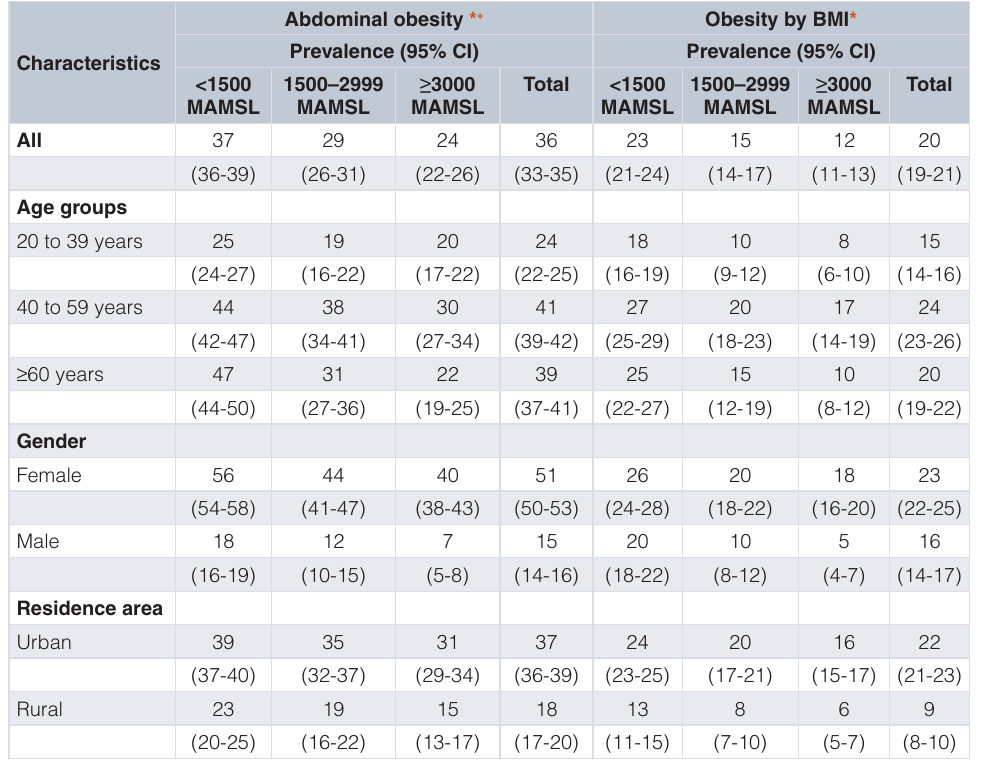
Table 4. Obesity and abdominal obesity prevalence by demographic at different